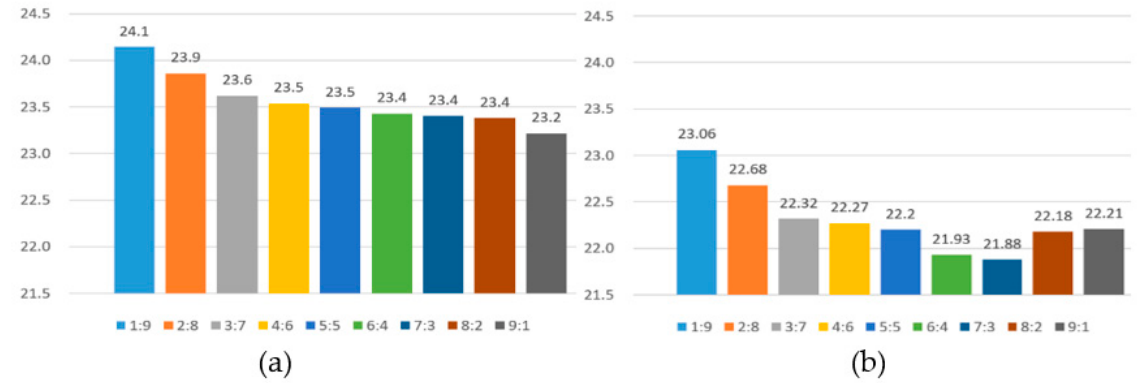
Figure 14. The RMSE of the estimated AQI and the actual AQI value; ( a ) invalid data is not excluded, ( b ) invalid data is excluded.